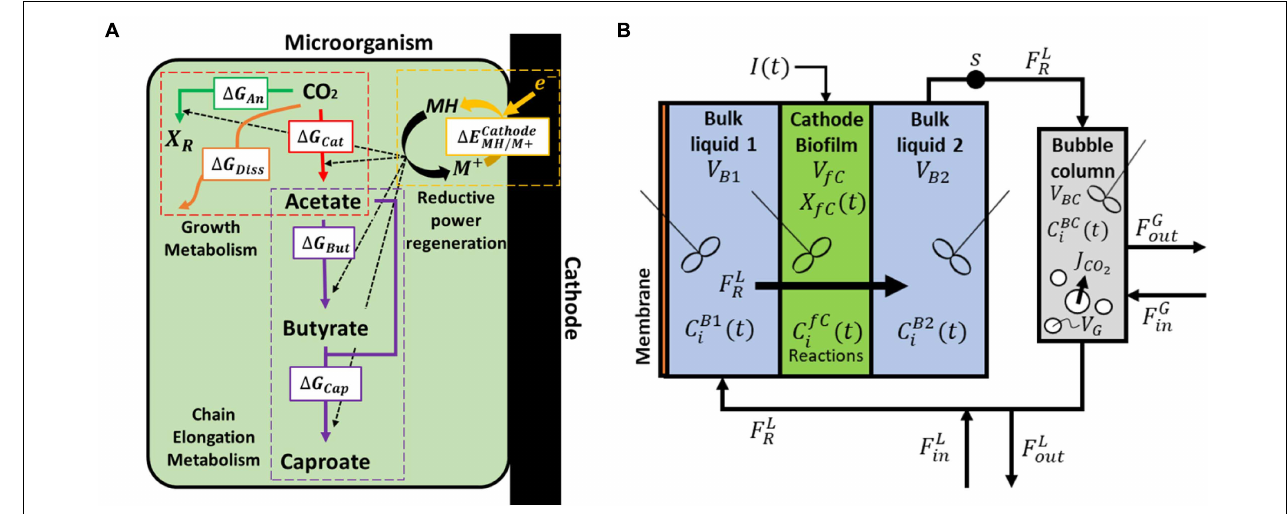
FIGURE 1 | (A) Biological and electrochemical reactions occurring within a single cell. The energy generated during the reduction of carbon dioxide (catabolism) is used for biomass formation (anabolism), butyrate and caproate formation (chain elongation), and partly dissipated as heat. The reductive power is regenerated in the bioelectrochemical reduction of the oxidized mediator M + and the excess of reduced mediator is used in the chain elongation metabolism. (B) Model domains of the continuous reactor based on Jourdin et al. (2019). CO 2 is supplied in the external bubble column during liquid recirculation and the catholyte is forced through a porous